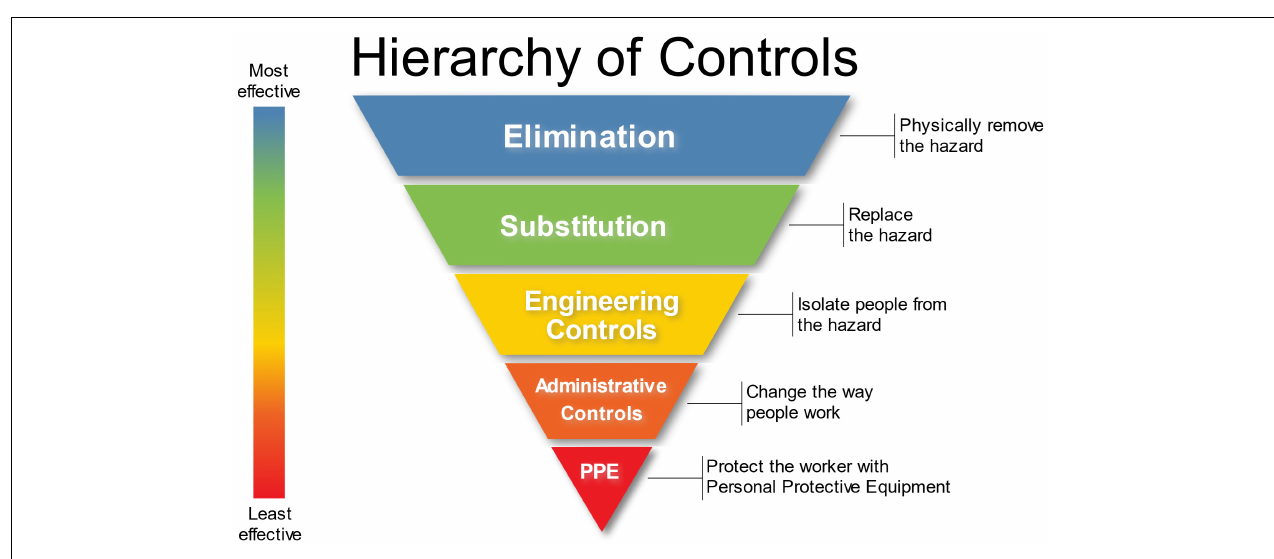
FIGURE 8 | Hierarchy of Controls in the Environmental Health and Safety Paradigm. Attribution: Original version: NIOSH Vector version: Michael Pittman, NIOSH’s “Hierarchy of Controls infographic” as SVG, CC0